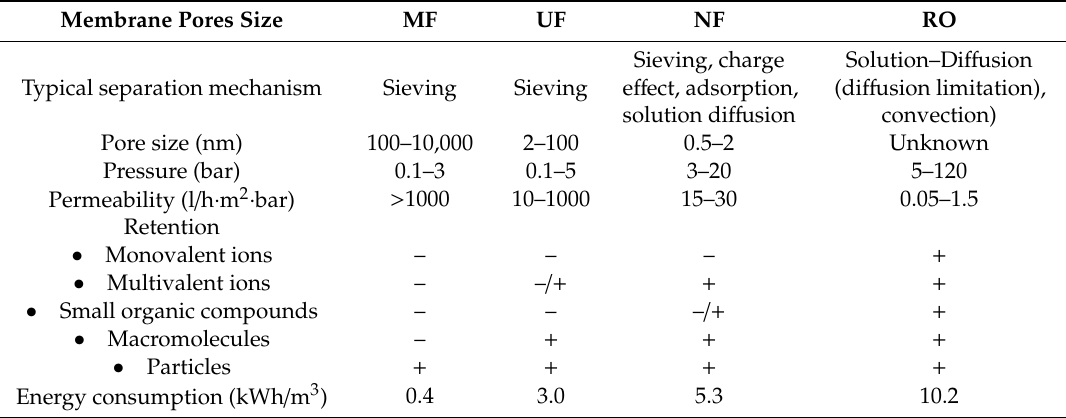
Table 1. General characteristic of membrane processes [60–65].